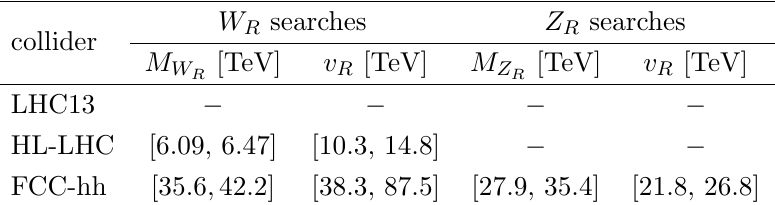
Table 4 . Lower bounds on the W R and Z R boson masses and the corresponding v R scale in the minimal LRSM from the current LHC13 data [30{32] and the prospects at the HL-LHC 14 TeV with an integrated luminosity of 3000 fb (cid:0) 1 [33, 74, 75] and future 100 TeV collider FCC-hh with a luminosity of 30 ab (cid:0) 1 [34, 36, 75], with both the gauge and scalar perturbativity limits up to the GUT scale taken into consideration. The range in each case corresponds to the allowed range of r g from perturbativity constraints, as given in (cid:12)gures 7 and 8. The missing entries mean that the corresponding maximum experimental reach has been excluded by the scalar perturbativity constraints. See text for more